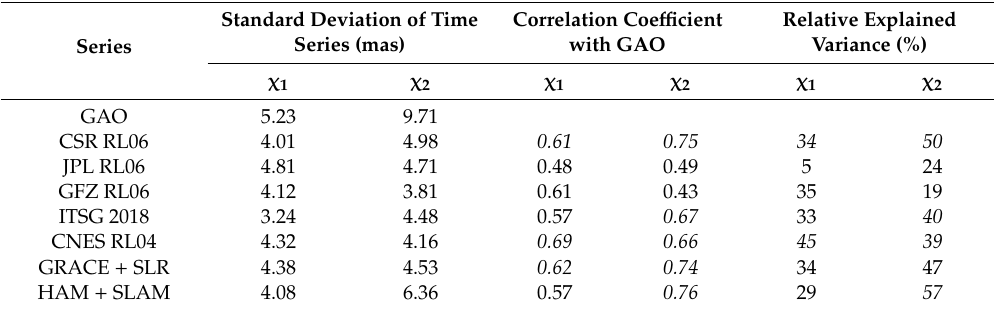
Table 8. Standard deviation of GSMAM, GAO, GRACE + SLR, and HAM + SLAM time series, correlation coe ffi cients with GAO, and percentage of variance in GAO explained by GSMAM, GRACE + SLR and HAM + SLAM. Oscillations with periods 100–450 days are considered. The critical value of the correlation coe ffi cient for 59 independent points and a confidence level of 0.95 is equal to 0.22. A standard error of a di ff erence between two correlation coe ffi cients for 59 independent points is equal to 0.19. The highest values of correlations and relative explained variances are